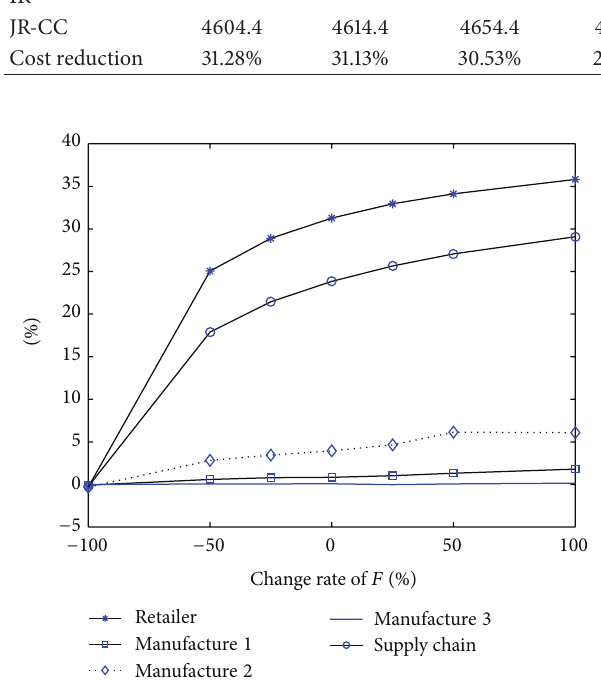
Figure 9: Impact of variation with 𝐹 on the cost reduction of the supply